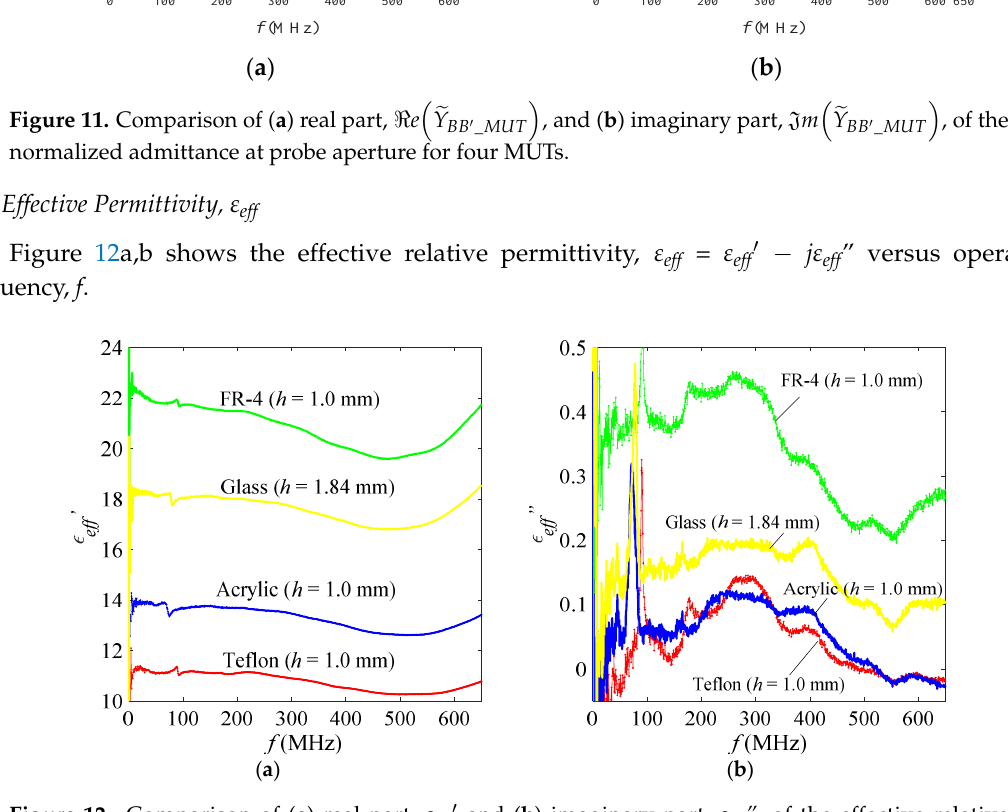
Figure 12. Comparison of ( a ) real part, ε eff ′ and ( b ) imaginary part, ε eff ″ , of the effective relative permittivity, ε eff for four MUTs.